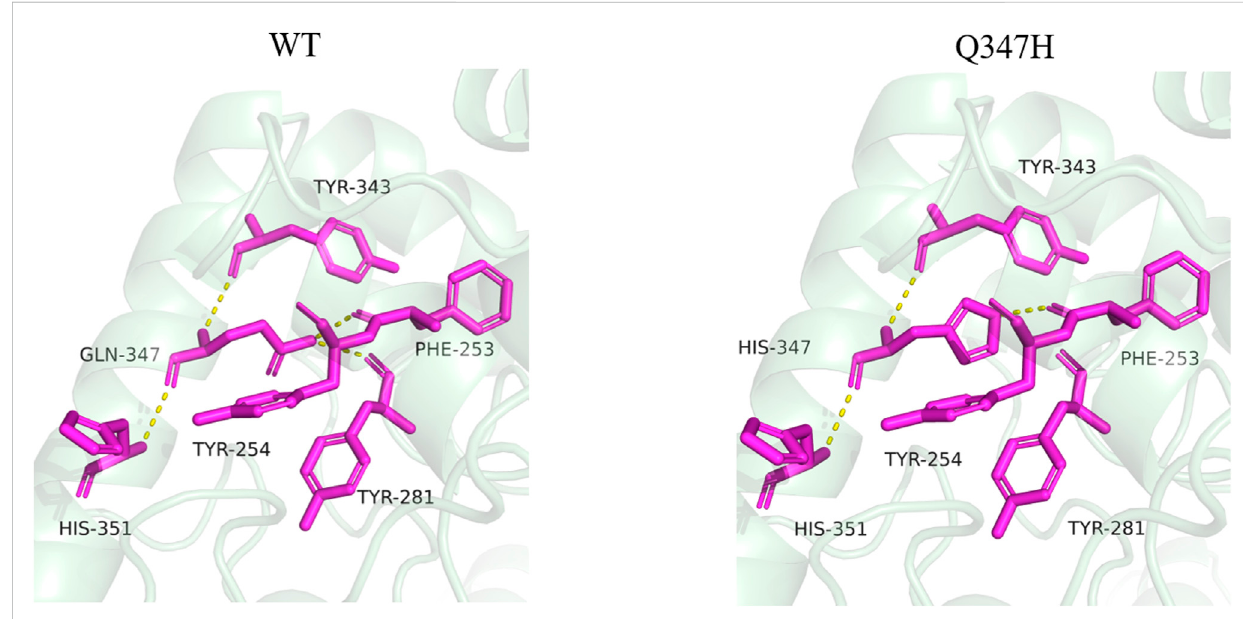
FIGURE 7 Changes of hydrogen bonds between amino acid residues at position 347 and surrounding amino acids before and after mutation. The yellow dotted lines in the fi gure represent hydrogen